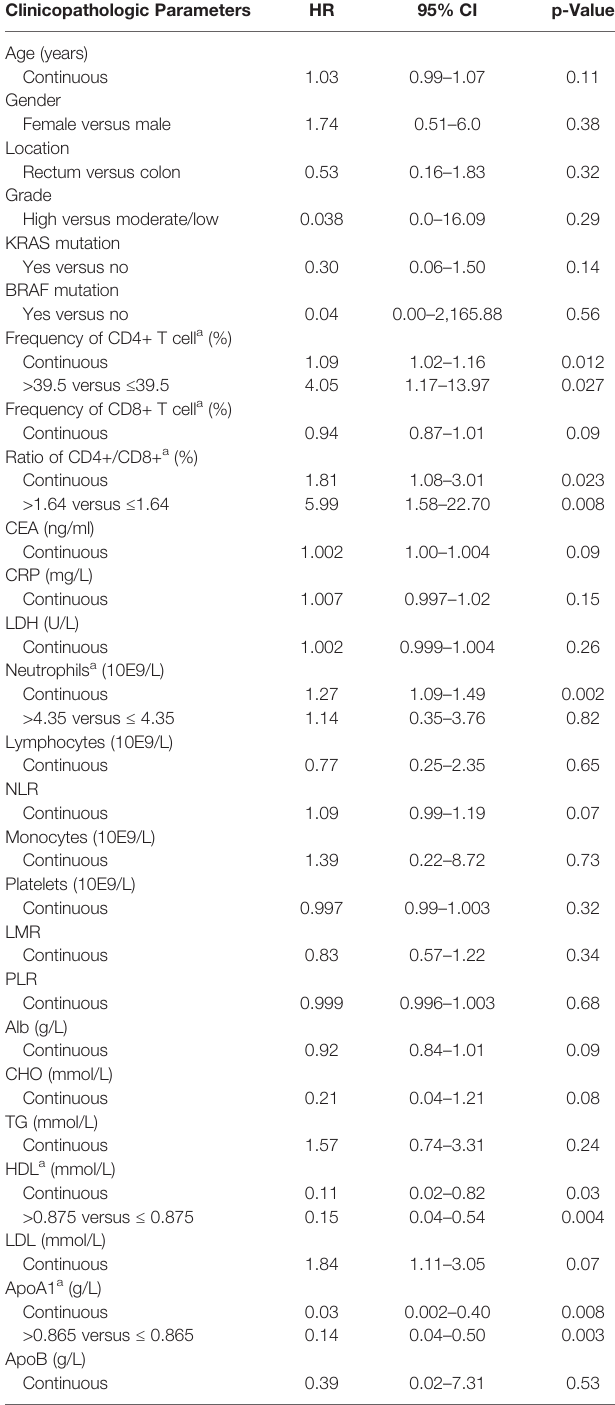
TABLE 2 | Progression-free survival and associations with clinicopathologic features using Cox regression.